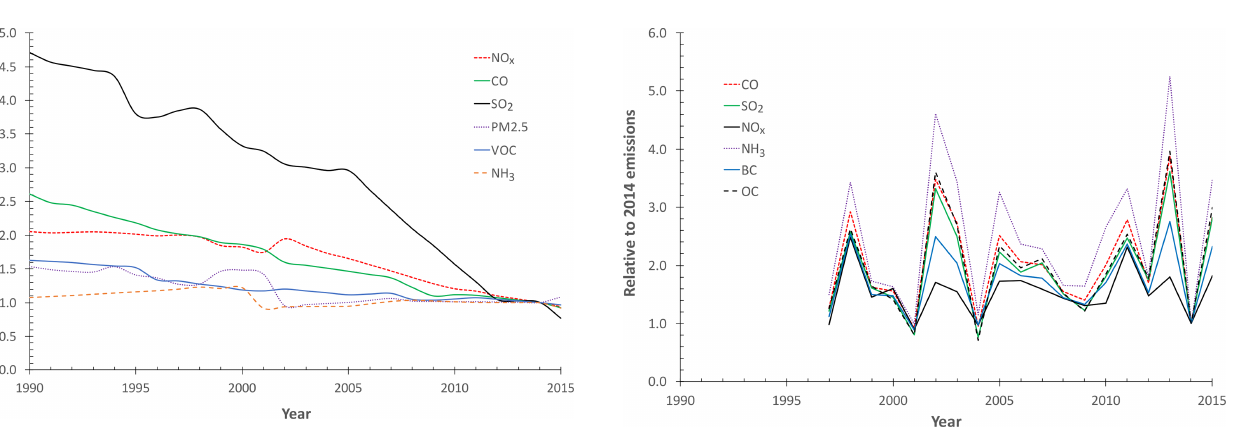
Figure 4. Fire emission evolution relative to 2014 in the model- ing domain from 1990 to 2015. Note that Global Fire Emissions Database (GFED) fire emissions are not available before